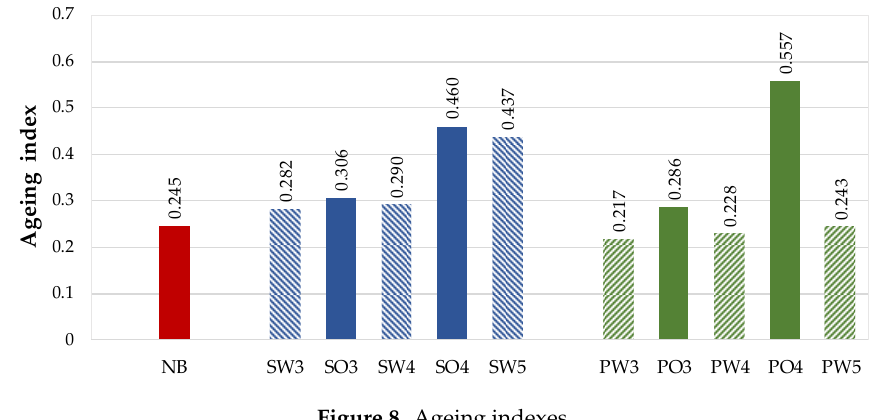
Figure 8. Ageing indexes.